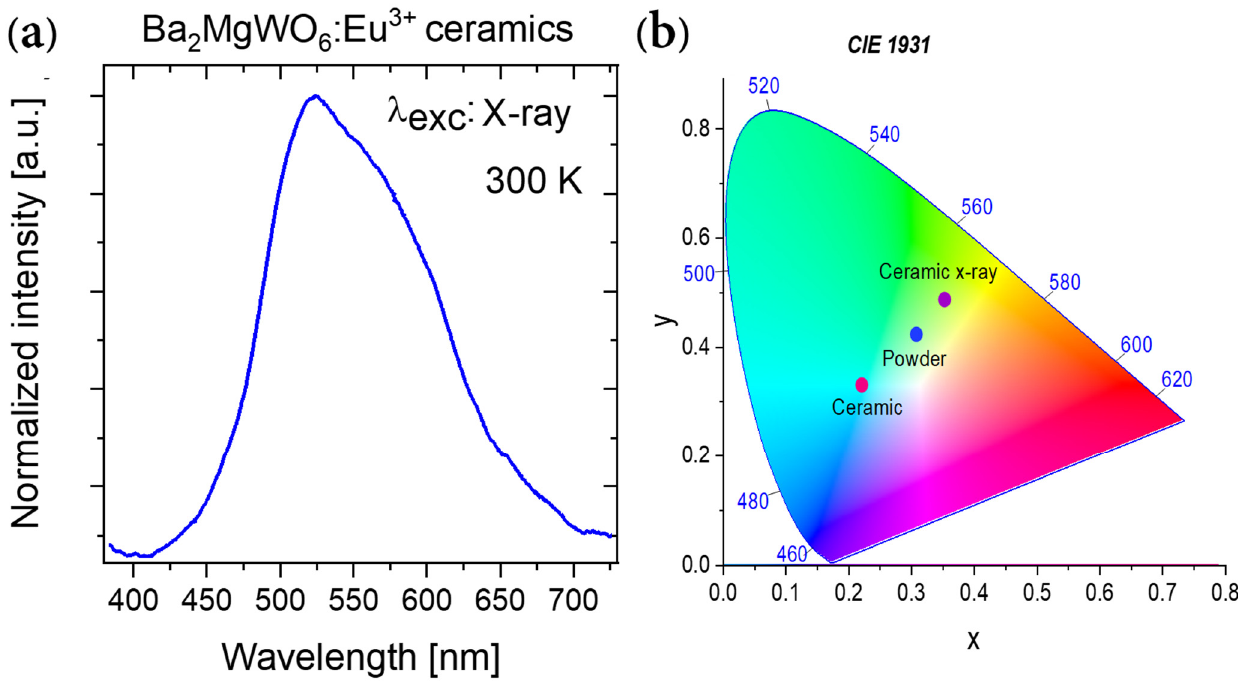
Figure 8. ( a ) 300-K (smoothed) emission spectra of BMW host ceramics under excitation of X-ray source (with 40 kV and 0.7 mA) and ( b ) CIE chromaticity of ceramic and powder BMW host under 266 nm and X-ray excitations.